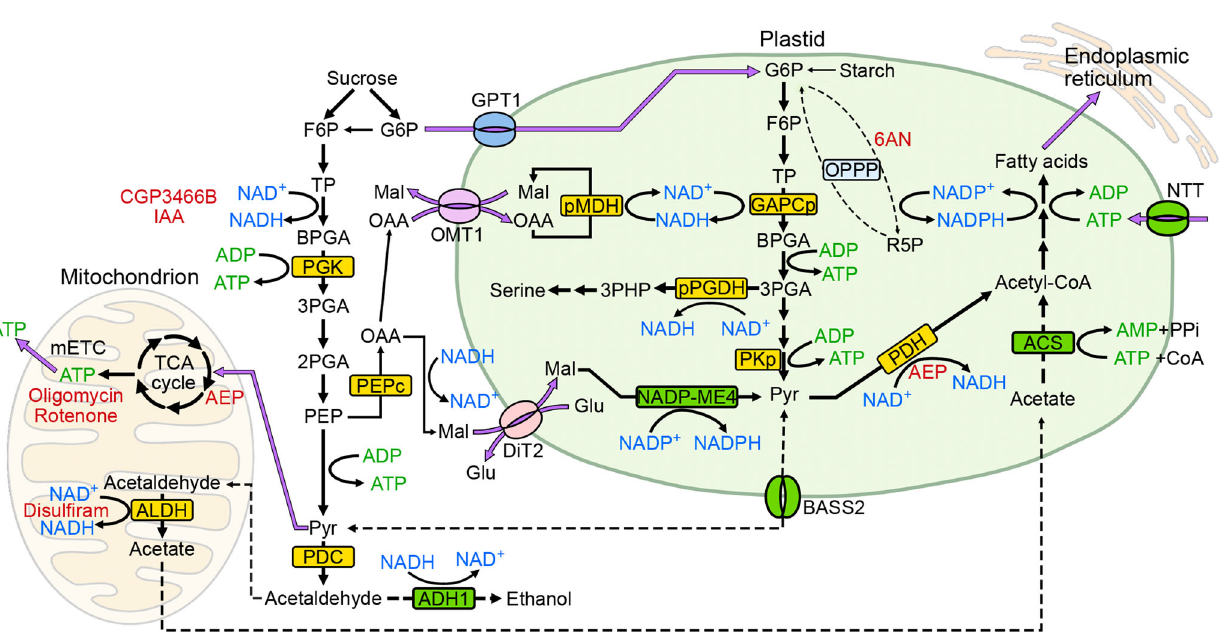
Fig. 8 | Model of the bioenergetics of Arabidopsis pollen tube growth. Exo- genous sucrose is the major source of energy, reducing equivalents and carbon skeleton for pollen tube growth. In the cytosol, F6P derived from sucrose is metabolizedviaglycolysistogenerateATP,NADH,PEP,andpyruvate.Inadditionto pyruvate, some of the PEP is converted into OAA by PEPc, which can be further reduced to malate. While pyruvate and malate can be used as substrates for mitochondria to generate ATP, cytosolic malate can also be importedinto plastids via DiT2, which in turn is converted into pyruvate by NADP-ME4 to supply NADPH for FA synthesis. Cytosolic G6P derived from sucrose is imported into plastids via GPT1,whichisbrokendownintopyruvateandgeneratesATPandNADHviaplastid glycolysis. Some imported G6P can also be used to generate NADPH via the OPPP pathway, although the NADP-ME4 pathway remains the major source of plastid NADPH. Unlike tobacco, PDH rather than the PDH bypass is the major source of acetyl-CoAandNADHforFAsynthesisinArabidopsisplastids.Inadditiontoplastid glycolysis,cytosolicATPisalsoimportedintothestromaviatheNTT2transporter. Unlike tobacco and lily, fermentation is not essential for Arabidopsis pollen tube growth.Inhibitorsandmutantsemployedinthisstudyarehighlightedinredandin